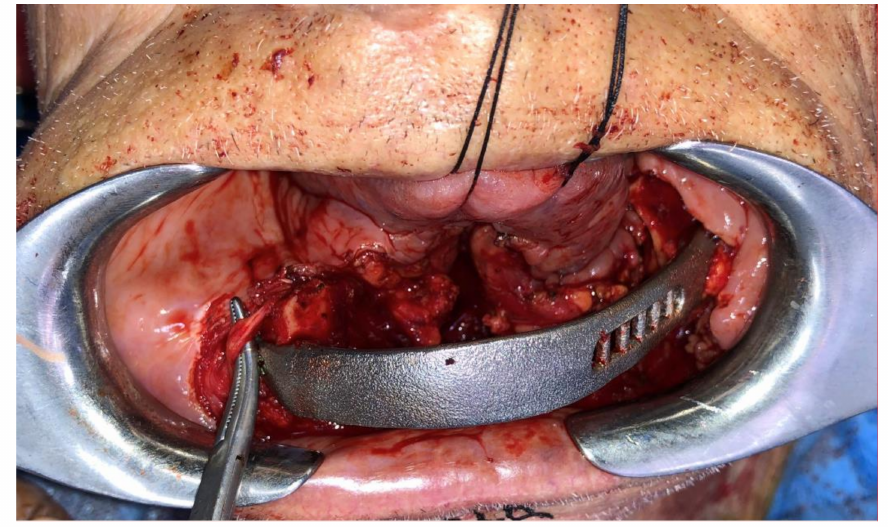
Figure 5. Fixation of the reconstructive